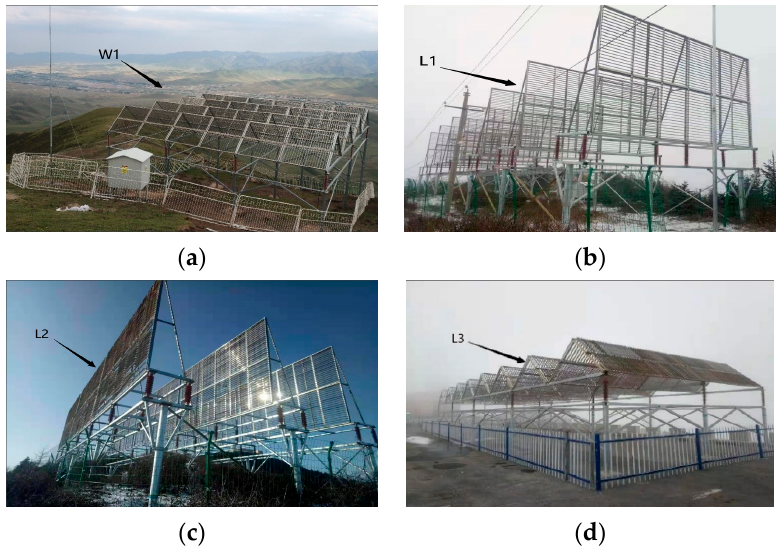
Figure 4. ( a ) The ground ‐ based negative ionization system in Wushaoling (W1); ( b ) The first ground ‐ based negative ionization system in Liupan Mountain (L1); ( c ) The second ground ‐ based negative ionization system in Liupan Mountain (L2); ( d ) The third ground ‐ based negative ionization system in Liupan Mountain (L3). Table 1 presents more detailed information on one ground ‐ based negative ionization system at Wushaoling and three at Liupan Mountain.